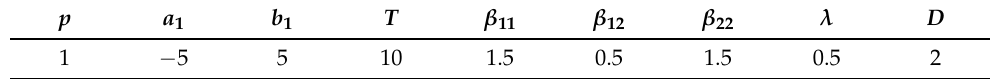
Table 1. Table of the parameter values employed in the numerical simulations of this work.